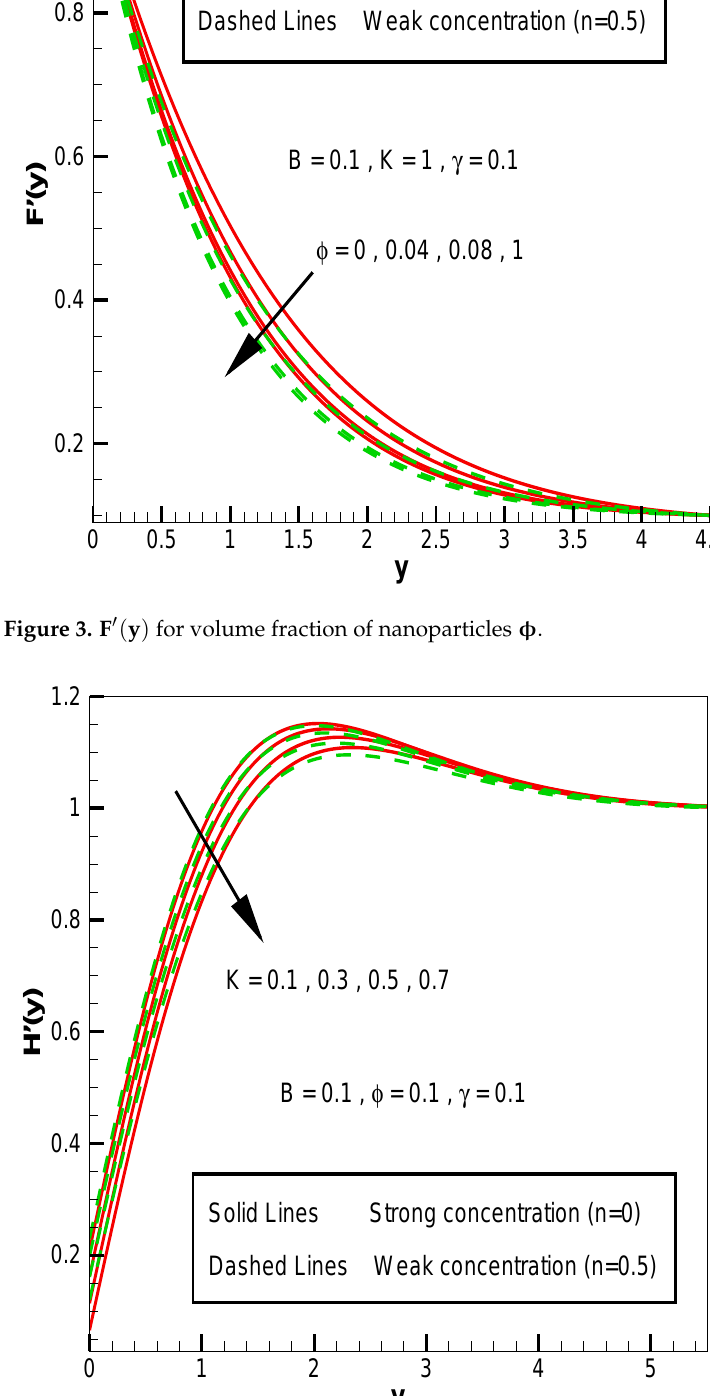
Figure 4. H (cid:48) ( y ) for material parameter K Figure 4. 𝐇 (cid:4593) (𝐲) for material parameter K.